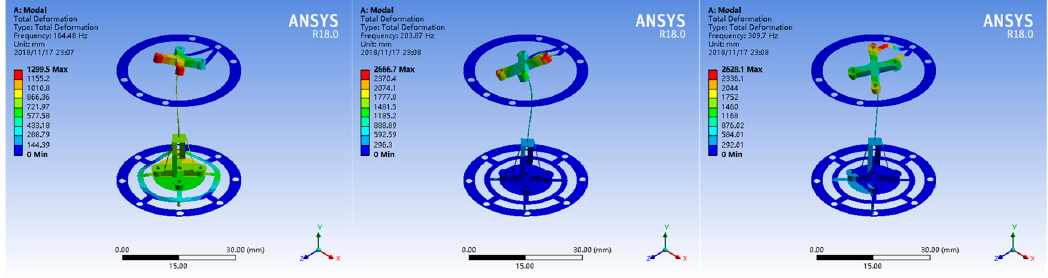
Figure 6. Mode analysis results of the probe: first order ( left ), second order ( middle ), third order ( right ).